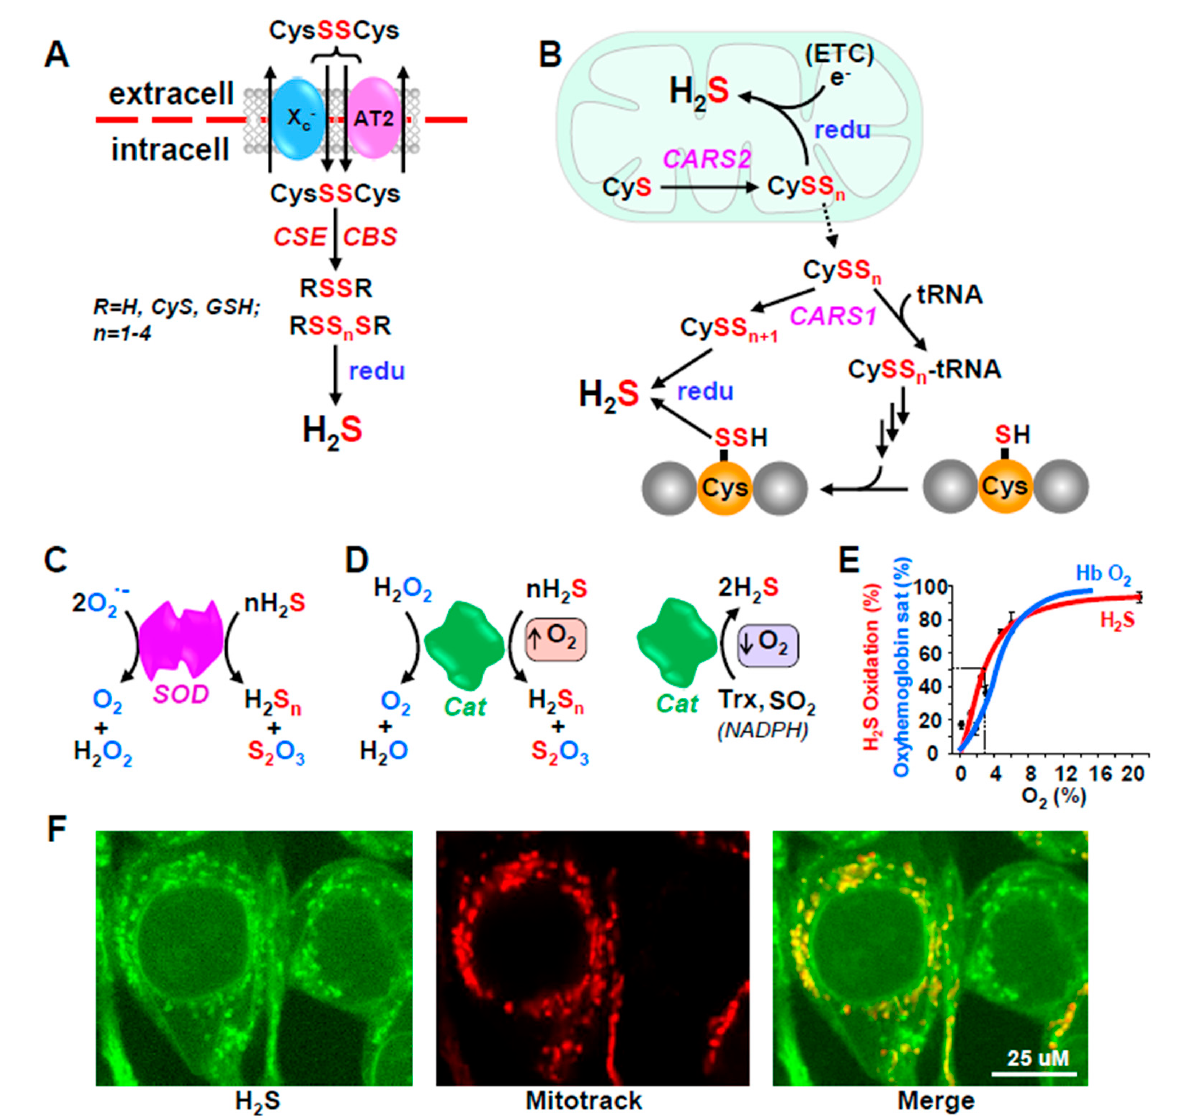
Figure 2. Additional redox-dependent mechanisms for H 2 S production from polysulfides ( A , B ) and catabolism by antioxi- dant enzymes ( C – F ). ( A ) Cystine (CysSSCys) is transported into cells by the cystine/glutamate antiporter, system, X c- or sodium-coupled neutral amino acid transporter (AT2). CSE and CBS then catalyze sulfur transfer to produce multiple polysulfides (RSS n SR) and H 2 S can be regenerated from these by intracellular reductants (redu) that are expected to increase under hypoxic conditions; the X c- antiporter is also up-regulated by preconditioning with hypoxia. ( B )